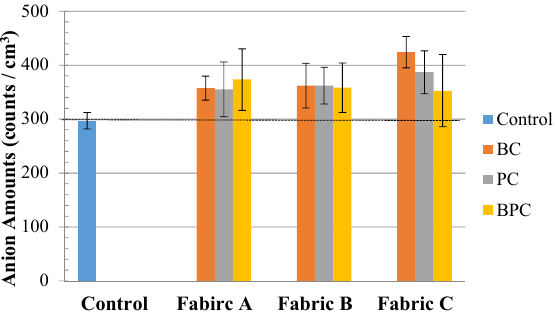
Figure 10. Anion amounts of elastic warp-knitted fabrics (Fabrics A, B, and C) made by BC, PC and BPC ring-spun complex yarns.